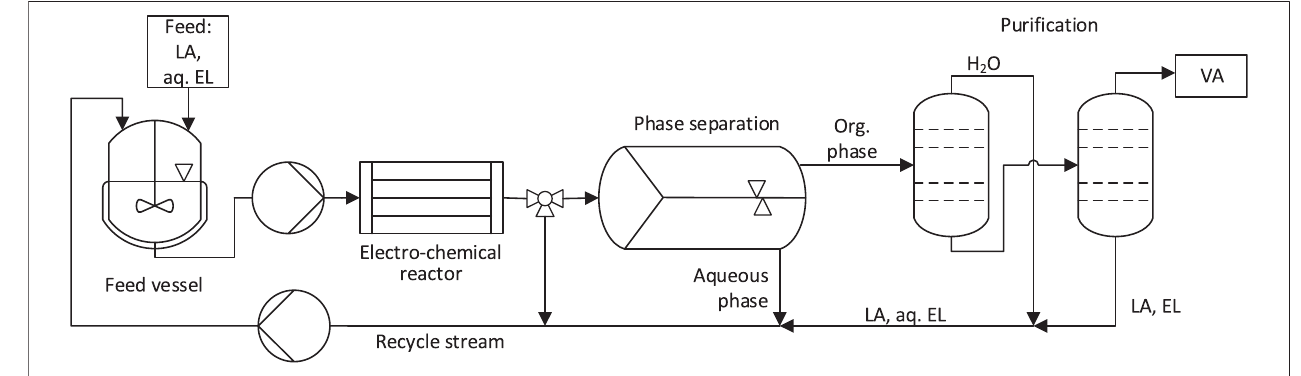
FIGURE 6 | Left: hypothetical process pathways and resulting organic and aqueous phase composition in steady-state continuous operation for different initial levulinic acid (LA) concentrations. Right: purity of the obtained organic product phase by means of valeric acid (VA) mass fraction and coulombic ef fi ciency of the electrochemical conversion (CE data from dos Santos et al., 2015) as a function of the initial LA concentration in a 0.5 M EL solution.